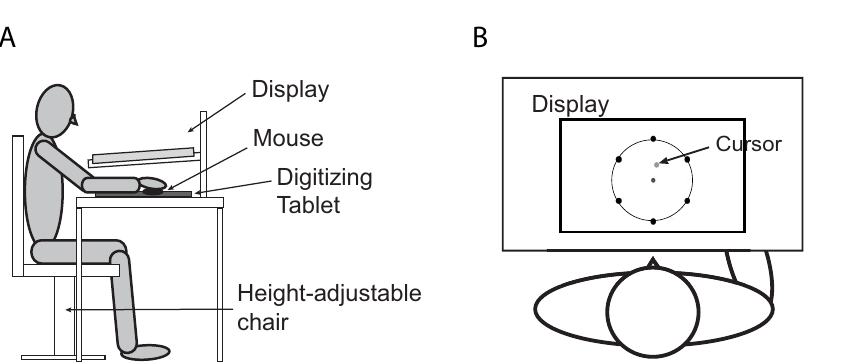
Fig 1. Experimental setup. (A) Subjects were seated on a height-adjustable chair placed in the front of the data acquisition device. They held a mouse in the hand and moved it to perform reaching movements on a digitizing tablet placed below the display. (B) In each movement trial, subjects made a reaching movement from start circle to one of six targets that appeared on the outer circle. Direct vision of the hand was blocked by the horizontal display; visual feedback was provided as a cursor indicating the mouse position on the